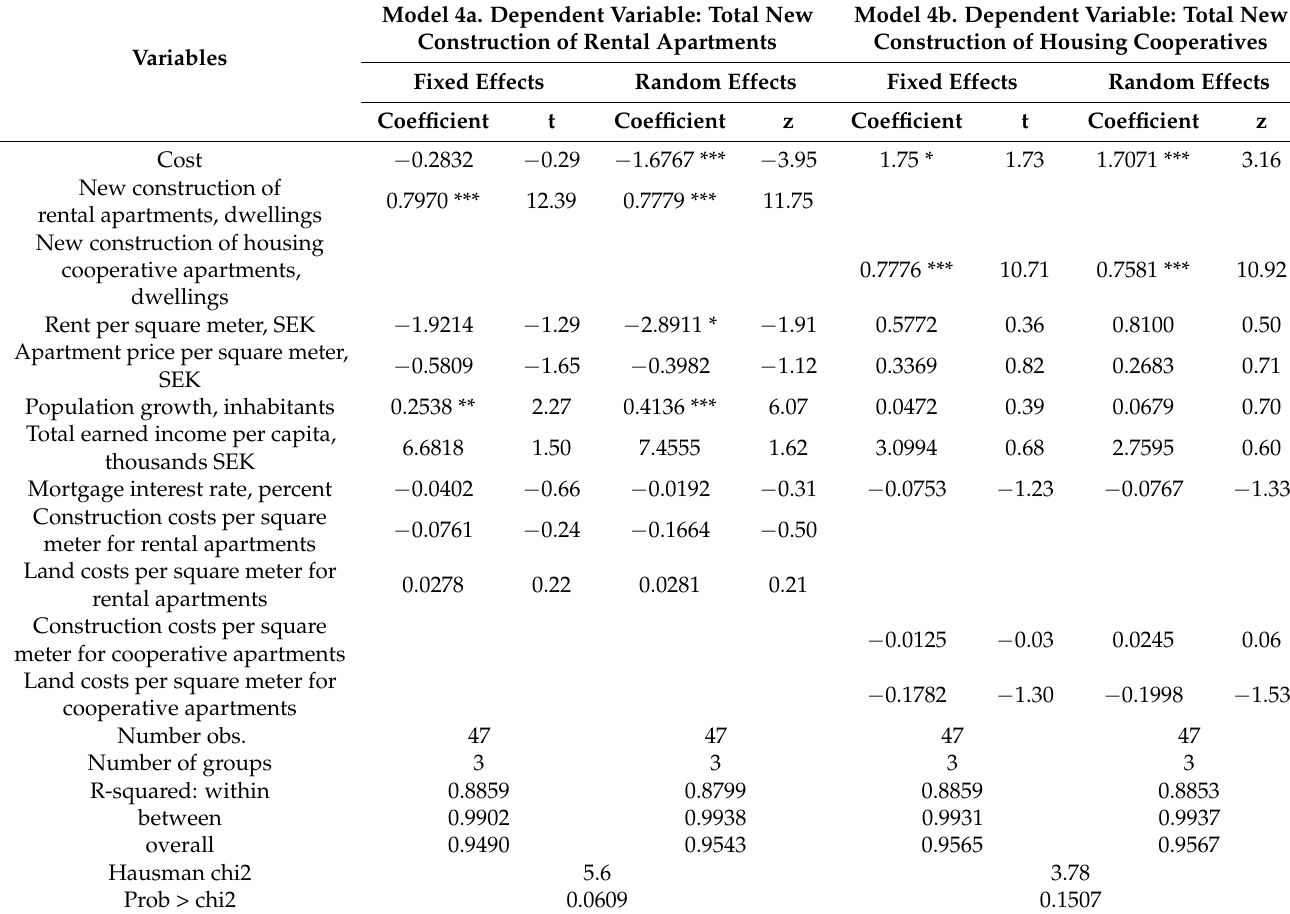
Table 7. Displacement effects for new apartments